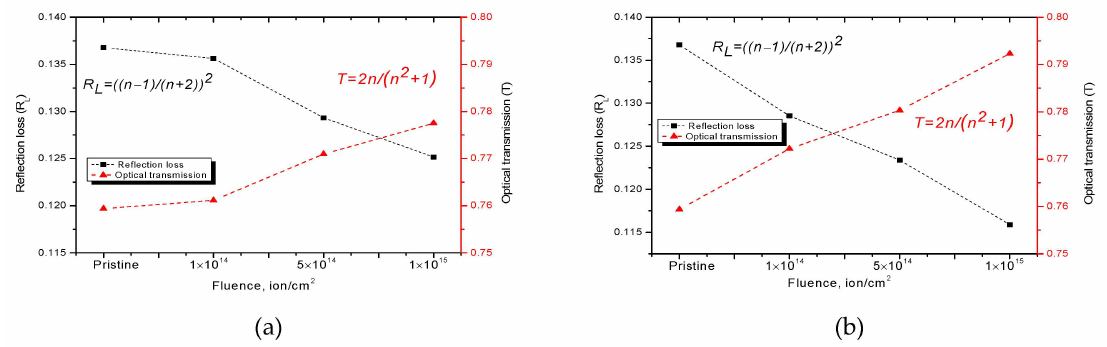
Figure 7. Reflection loss R L and optical transmission T for: ( a ) the Kr 15 + ion irradiated dose; ( b ) the Xe 22 + ion irradiated